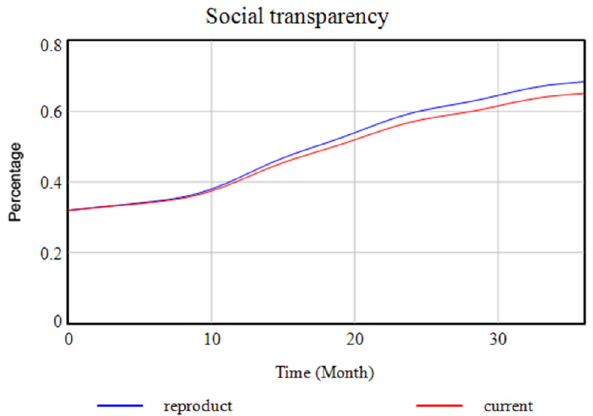
scenario, the legal requirement rate is about 50%, and it is assumed that environmentally destructive companies will have to pay 5% more